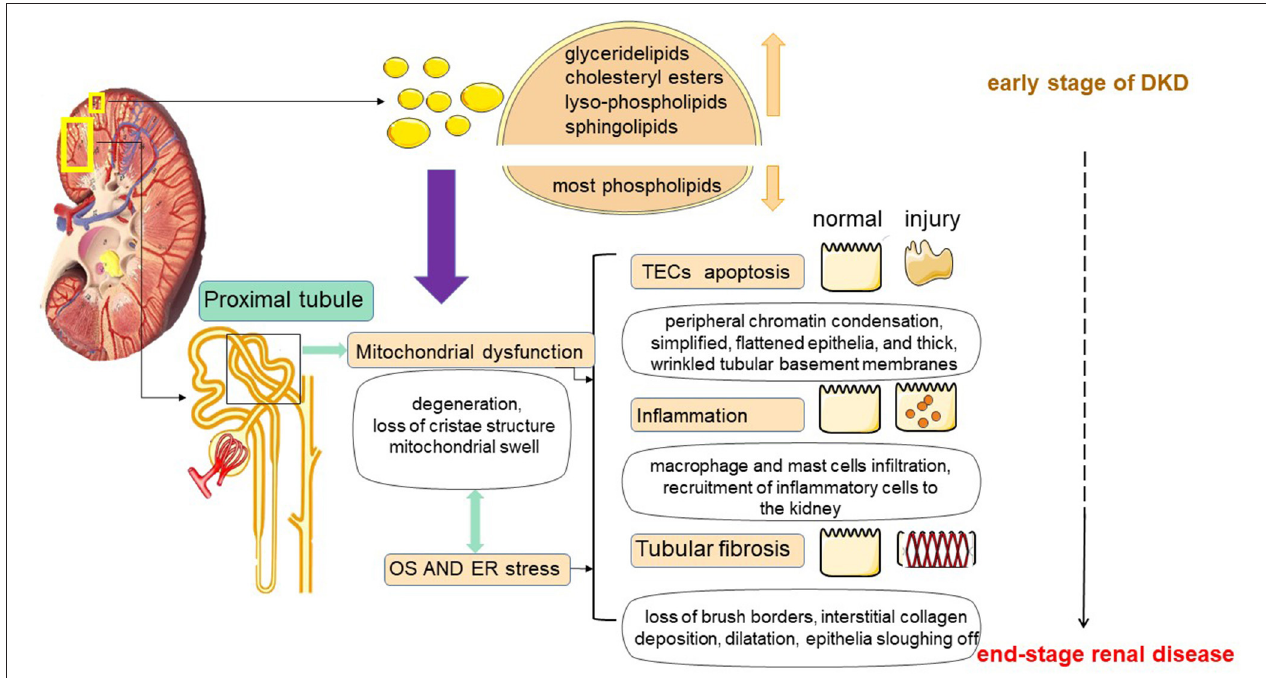
FIGURE 2 | Lipotoxicity-mediated tubular injury. Tubular lipotoxicity leads to the development of a series of renal injuries including tubular epithelial cell apoptosis, inflammation and tubulointerstitial fibrosis. First, in renal tubules, lipotoxicity may cause mitochondrial dysfunction, involving massive ROS production, and inducing oxidative stress (OS) and ER stress. Second, lipotoxicity may cause OS and ER stress, which in turn may cause mitochondrial damage. At the same time, OS and ER stress may also cause damage to mitochondria. In addition, mitochondrial dysfunction, OS and ER stress together do harm to tubular